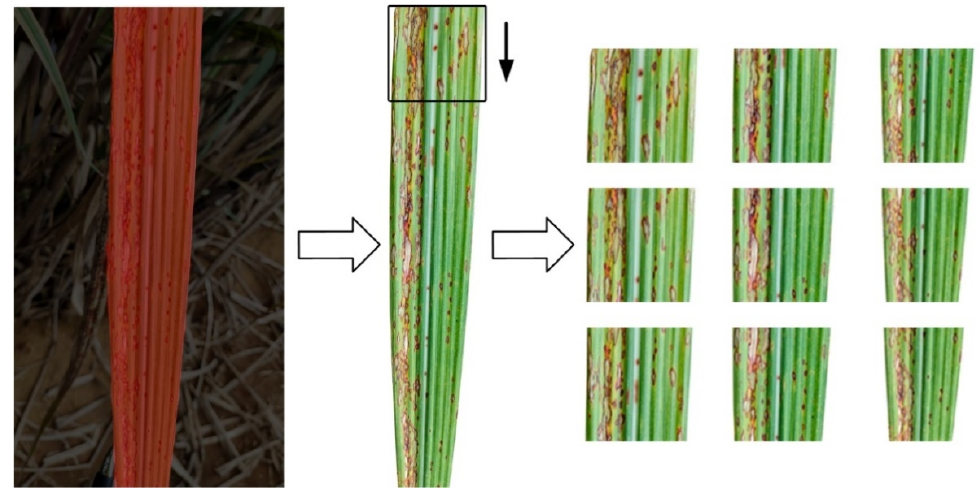
Figure 10. Image segmentation